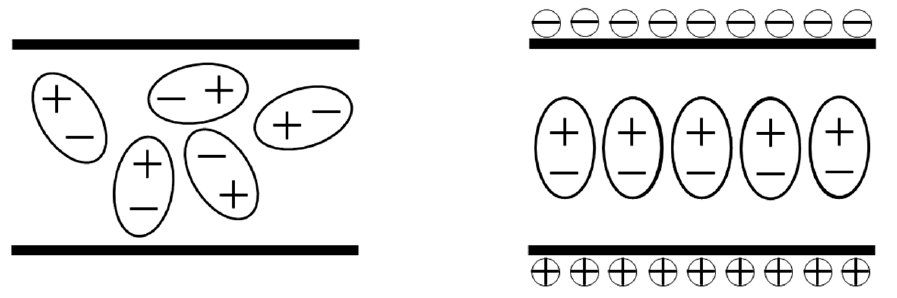
Figure 1. The microwave-absorbing principle of